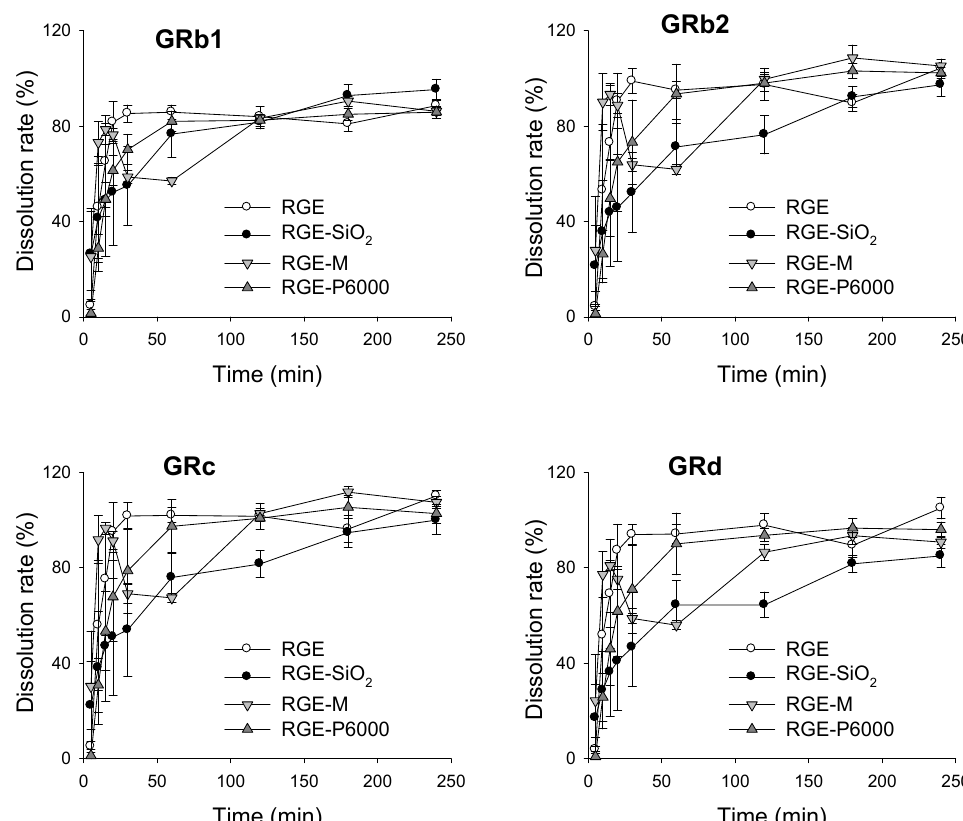
Figure 6. Dissolution profiles of ginsenoside Rb1 (GRb1), GRb2, GRc, and GRd from the solid dispersions of red ginseng extract (RGE), RGE-SiO 2 , RGE-M, and RGE-P6000 were measured using the paddle method for 240 min. Data represent the mean ± standard deviation ( n = 3).